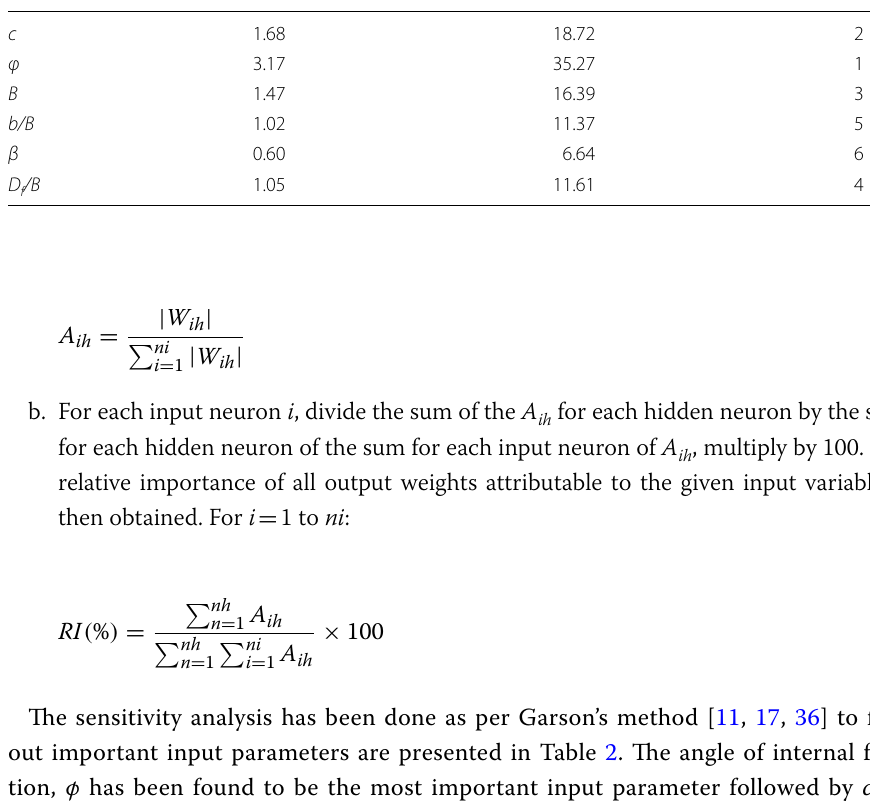
Table 2 Relative importance of input-parameters from Garson’s algorithm